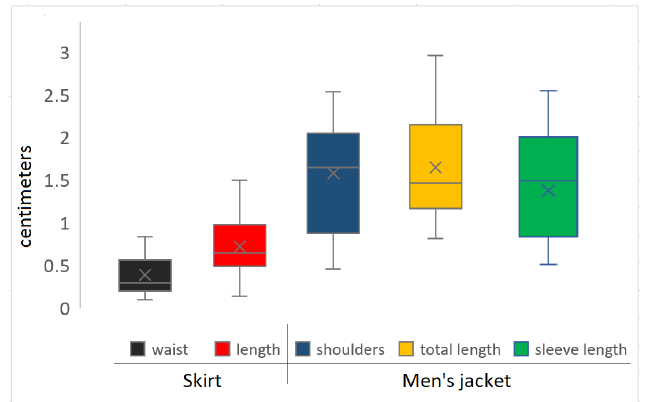
Figure 9. The error of manual measurement for two different types of clothes: skirts and men’s